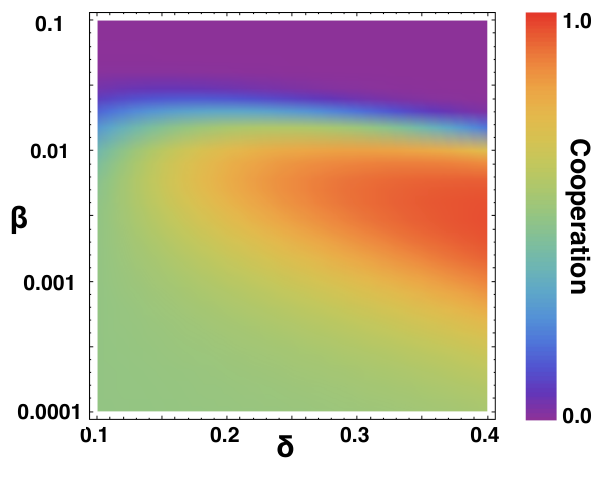
Figure 7. Role of the range of behavioral spectrum ( δ ) and selection pressure ( β ) in the evolution of cooperation. Each contour region represents the fraction of time the population spends in a cooperative state (of any type), for given values of δ and β . The number of types in the population was changed so as to keep the interval in δ between consecutive types constant (0.01). Specifically, δ = 0 . 3 leads to 60 types in the population. ( N = 100 , T = 2 . 1 , R = 2 , P = 1 , S = 0 . 9 , c = 0 . 16